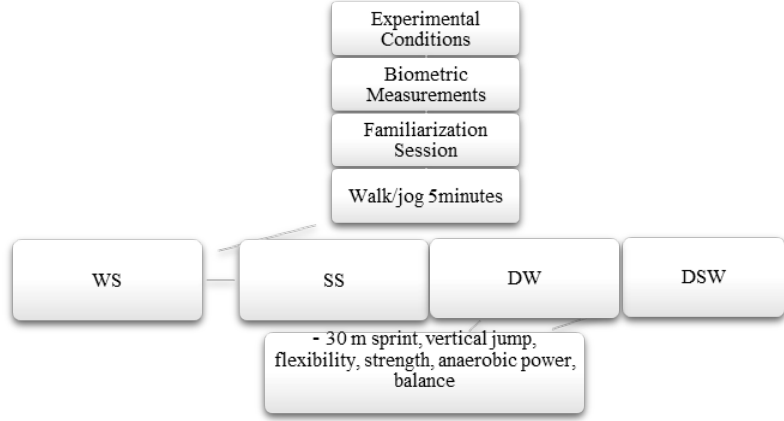
Figure 1. Experimental